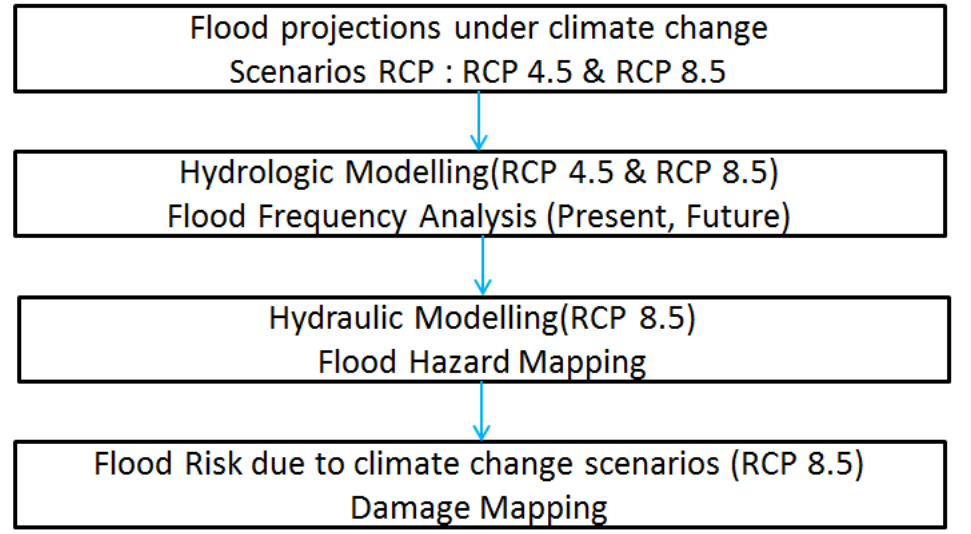
Figure 3. Steps for estimating the impacts of climate change on future flood hazard and damage.